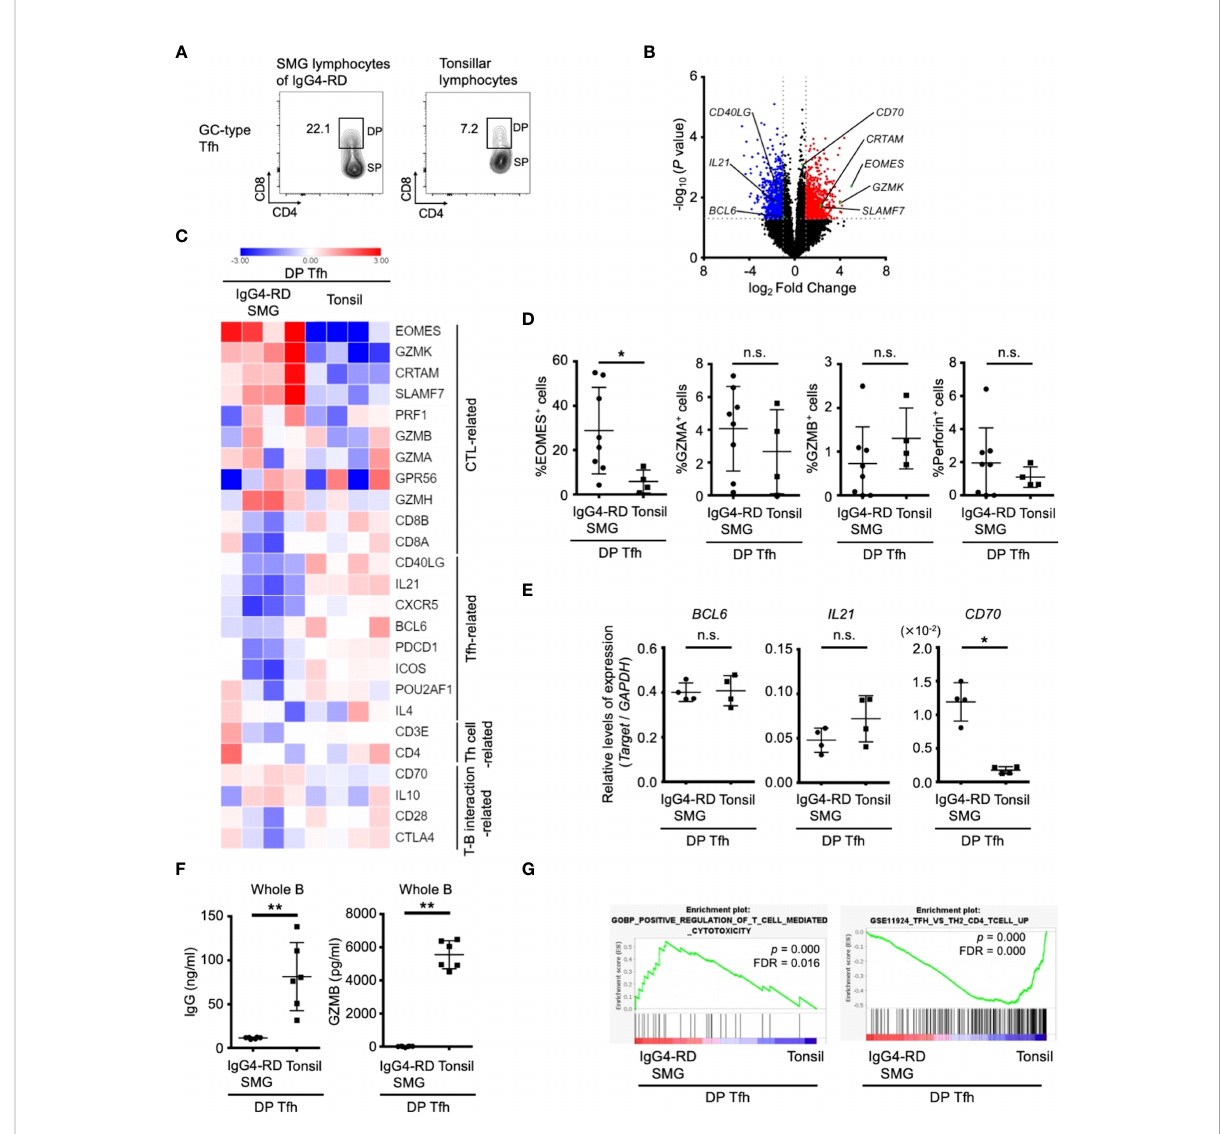
FIGURE 5 Features of DP-Tfh cells in in fl ammatory lesions of IgG4-RD. (A) Representative fl ow cytometry pro fi les of DP-Tfh cells and SP-Tfh cells in GC- type Tfh cells in the lymphocytes of tonsils and SMG lesions of IgG4-RD. (B) Volcano plot showing differentially expressed genes ( p < 0.05) with more than two-fold expression in DP-Tfh cells localized in SMG lesions of IgG4-RD versus those in tonsils. Red and blue dots indicate the upregulated and downregulated genes, respectively, in the DP-Tfh cells of IgG4-RD. Data were obtained from microarray analysis of four specimens in each experimental group. (C) Heat map representing the relative abundances of transcripts identi fi ed in (B) for selected genes involved in the functioning and regulation of helper CD4 + T cells and CTLs. Relative values of gene expression are indicated by color. (D) Expression of CTL-related molecules in DP-Tfh cells of SMG lesions of IgG4-RD (n = 8) and tonsils (n = 4) as assessed by fl ow cytometry. (E) Relative levels of gene expression in DP-Tfh cells of SMG lesions of IgG4-RD (n = 4) and tonsils (n = 4) as indicated in (B) analyzed by RT-qPCR. GAPDH was used as a control. (F) Lower B-cell helper capacity of DP-Tfh cells in IgG4-RD lesions than in tonsils. The levels of IgG and granzyme B (GZMB) in supernatants from co-cultures of DP-Tfh cells with autologous whole B cells (CD3 - CD19 + ) under stimulation of CD3 and CD28 were analyzed by ELISA on day 7 after initial incubation (IgG4-RD, n = 6; tonsil, n = 6). (G) Gene set enrichment analysis (GSEA) of genes identi fi ed in (B) showing transcriptomes of DP-Tfh cells. Results from gene sets associated with cytotoxic T cells or Tfh cells are shown on the left and right, respectively. Data in (D – F) were analyzed by the Mann – Whitney U